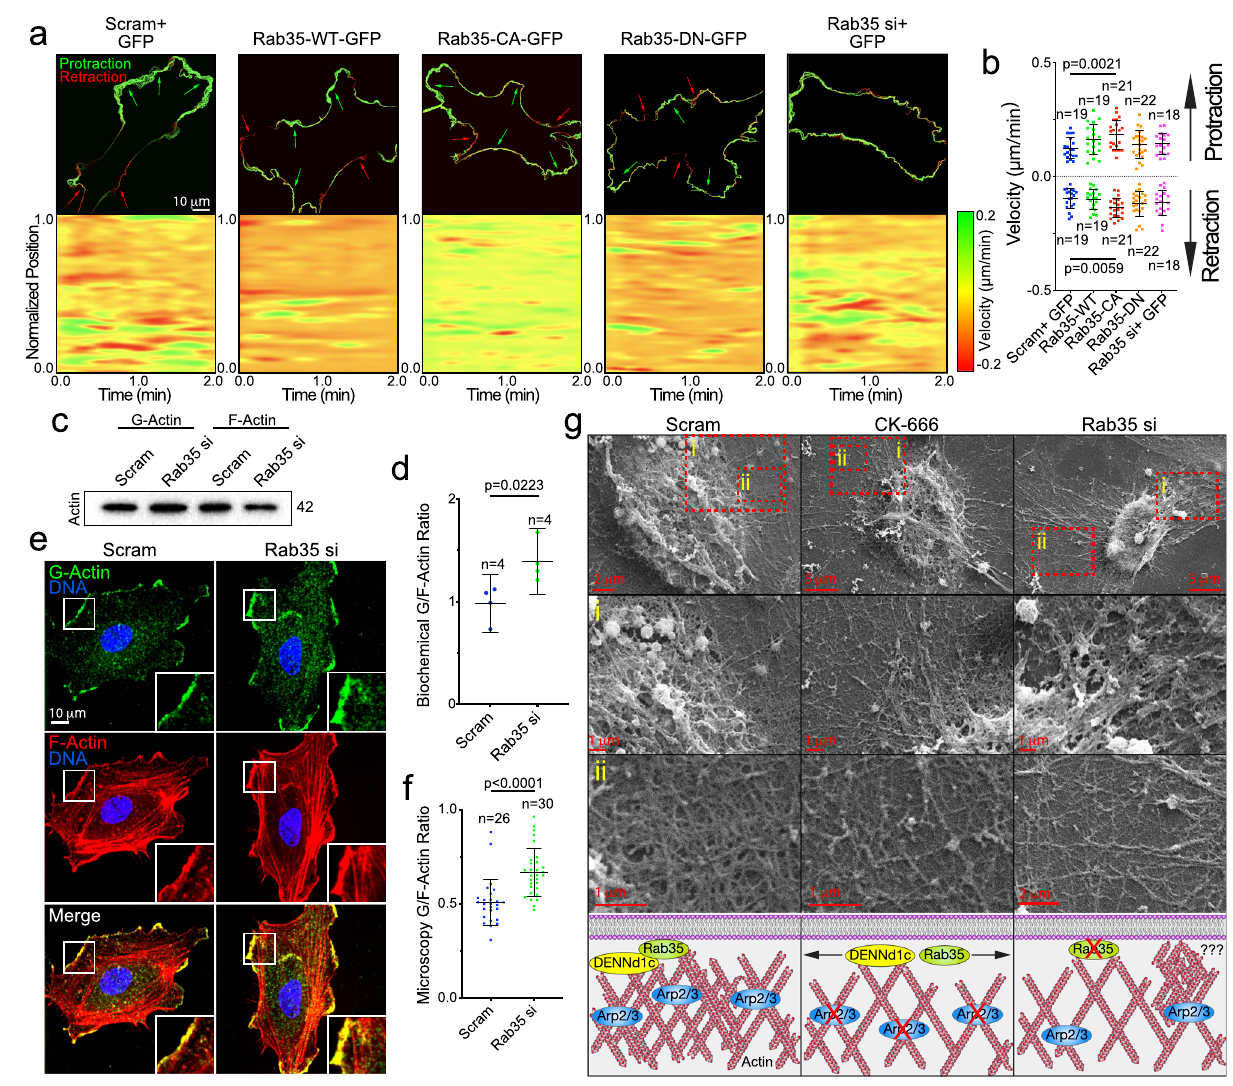
Fig.7|Rab35regulatesactindynamics.a Toppanelsdepictchangeinmembrane velocities over time in described conditions. Green represents protraction and red representsretractionofcellmembrane.Arrowsindicatedirectionality.Thebottom panels are heat maps in which the Red is indicative of retractive movement and green is protractive movement over time. Yellow indicates no change in velocity. b Quanti fi cation of cell membrane velocities between indicated groups. Above the dashed line is the protractive velocities and below the dashed line is retractive velocities. n =numberofcells.Errorbarsrepresentstandarddeviation,middlebars are the mean. c Westernblot of globular( G )and fi lamentous( F ) actininsiRNA(si)- treated groups. d Quanti fi cation of the ratio of globular to fi lamentous actin from blots represented in panel ( c ). n =number of cells. Error bars represent standard